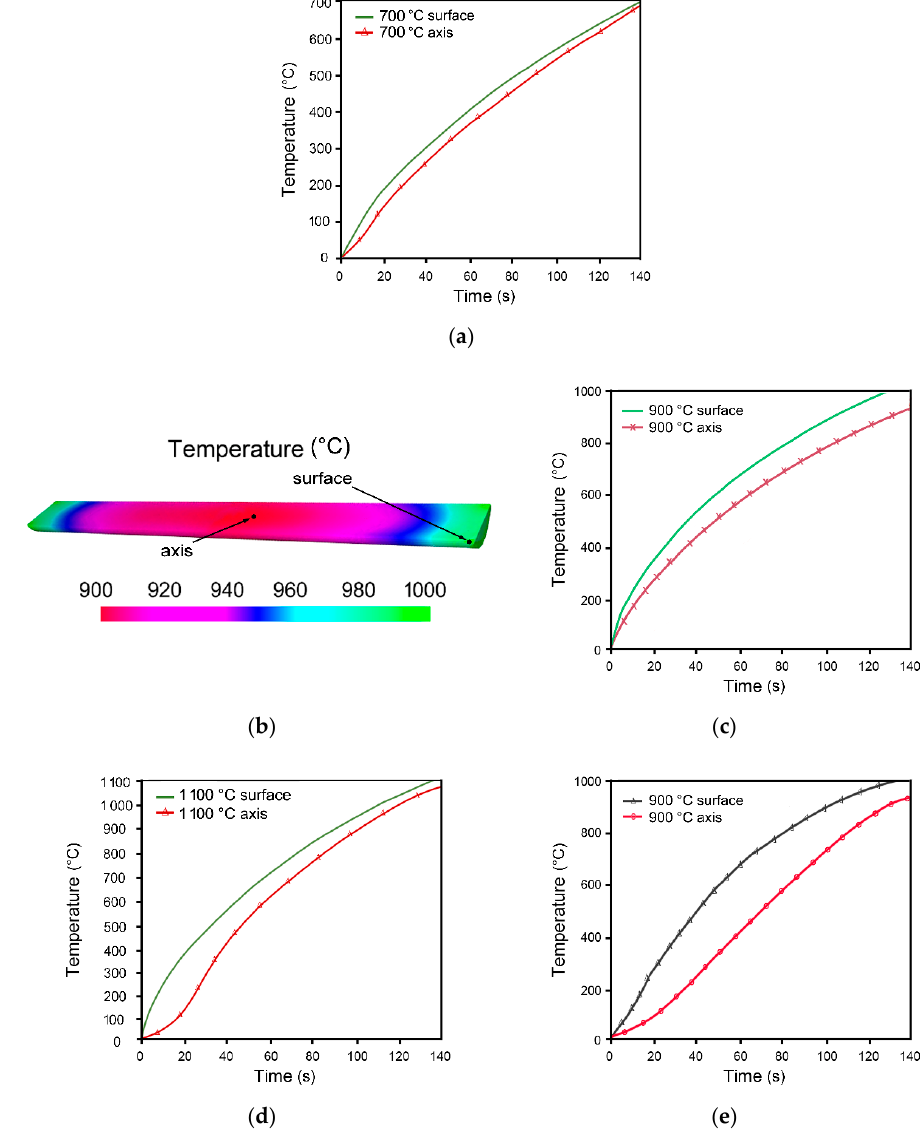
Figure 7. Heating time- and temperature-dependences of the axial and surface workpiece regions during: simulated heating to 700 °C ( a ); simulated heating to 900 °C ( c ); simulated heating to 1100 °C during: simulated heating to 700 ◦ C ( a ); simulated heating to 900 ◦ C ( c ); simulated heating to 1100 ◦ C ( d ); ( d ); experimental heating to 900 °C ( e ). Temperature distribution throughout billet heated to 900 °C experimental heating to 900 ◦ C ( e ). Temperature distribution throughout billet heated to 900 ◦ C ( b ( b ).